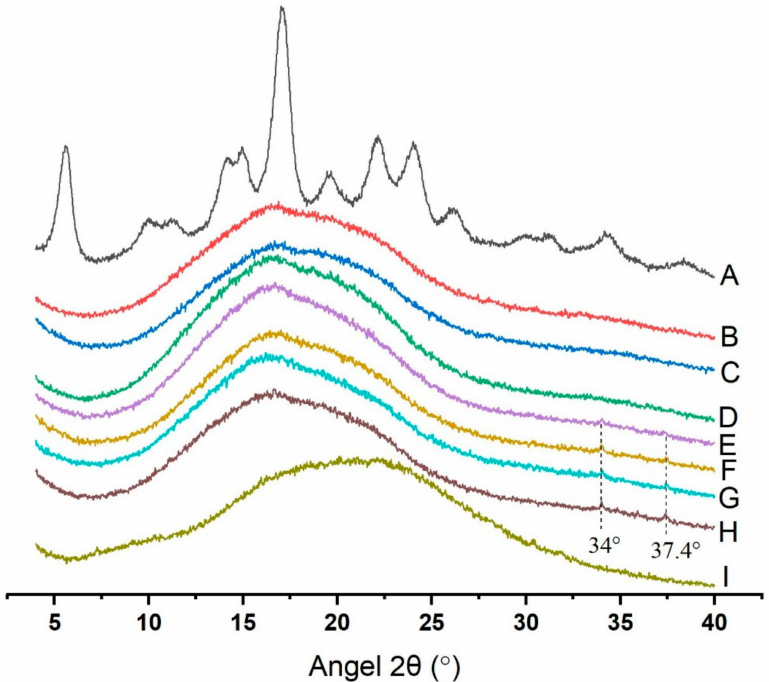
Figure 1. X-ray di ff raction analysis of the native starch, GSP–potato starch complexes and GSP. (A) Native starch; (B) Starch + 0.0% GSP; (C) Starch + 1.0% GSP; (D) Starch + 2.0% GSP; (E) Starch + 3.0% GSP; (F) Starch + 4.0% GSP; (G) Starch + 4.5% GSP; (H) Starch + 5.0% GSP; (I)